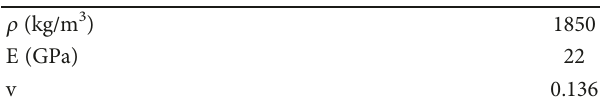
Figure 5: (a) Bolted connections, (b) inner structure, and (c) boundary conditions. Table 2: FR4